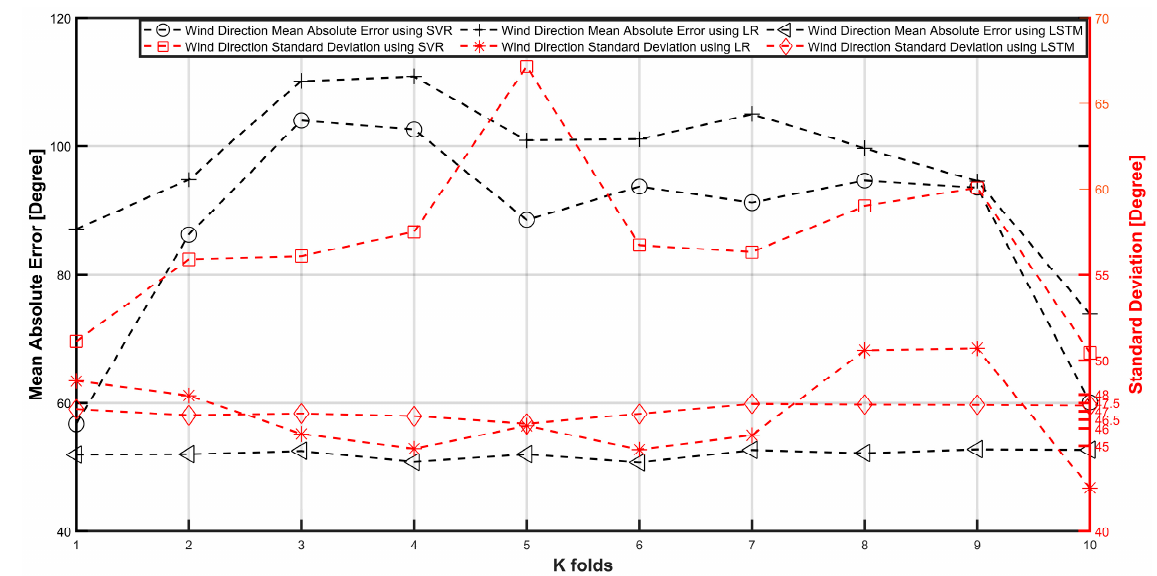
Figure 4. Wind speed variation in K folds.